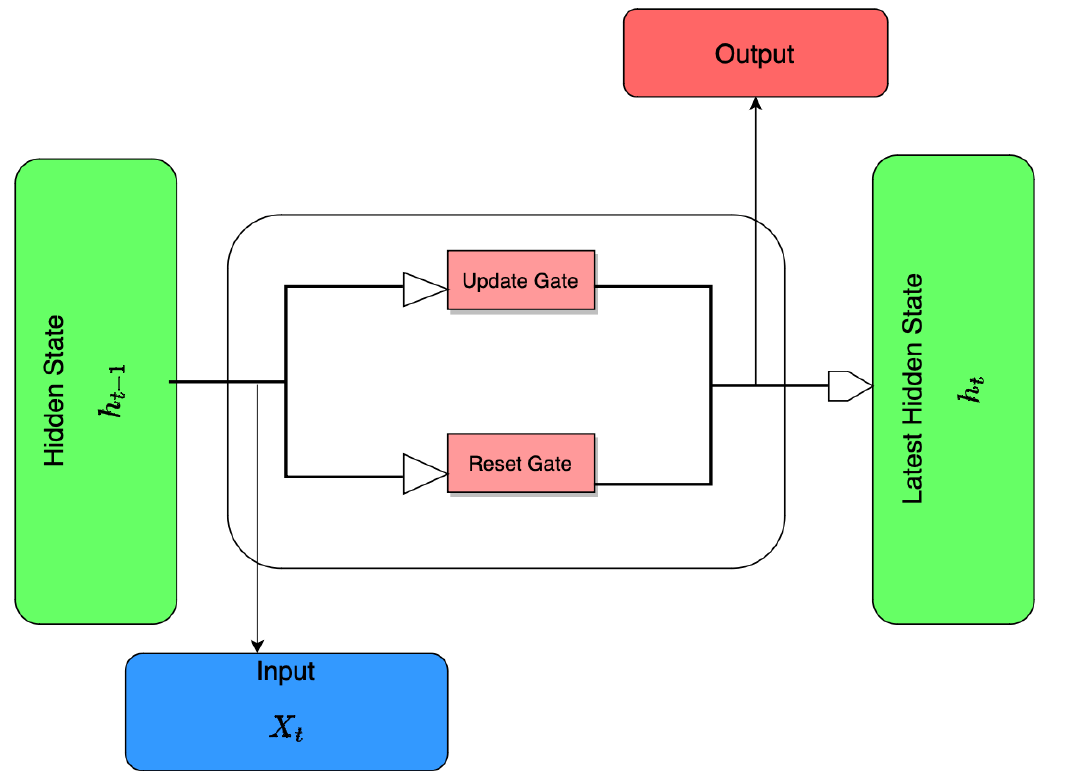
Figure 9. The diagram of a GRU